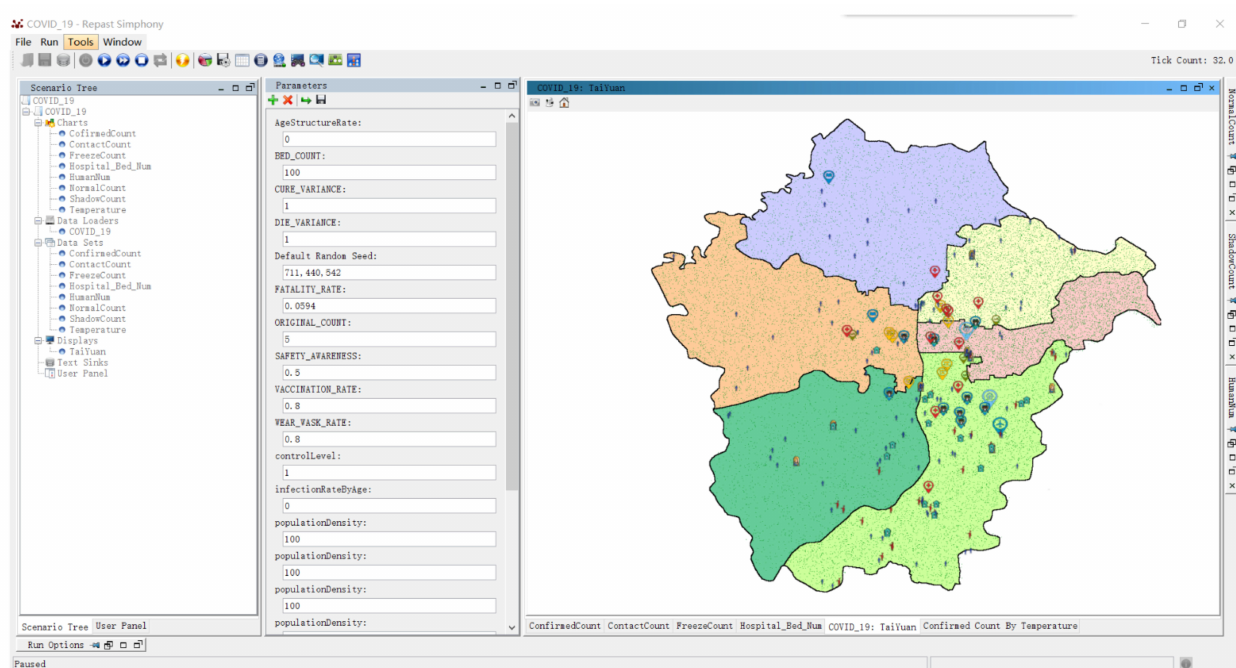
Figure 3. Model operation interface